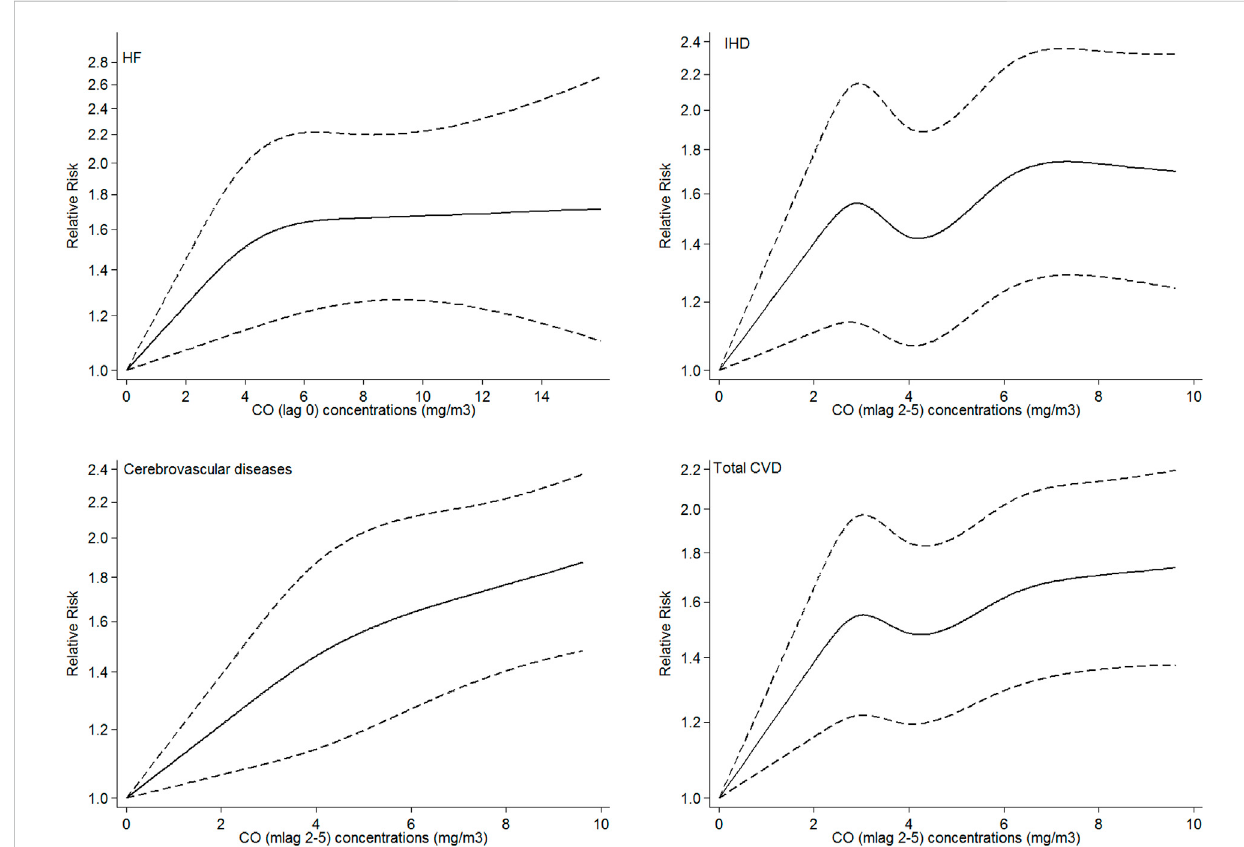
FIGURE 2 Adjusted exposure – response curves of exposure to CO with hospital admissions for HF, IHD, cerebrovascular disease, and total CVDs. The black solid lines represent the relative risk of hospital admissions, and the dotted lines represent the corresponding 95% con fi dence intervals. For each disease the most effective lag was